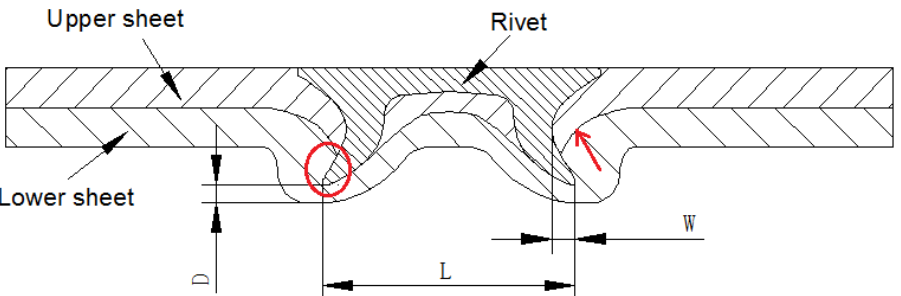
Figure 4. Cross-sectional profiles of an SPR joint.